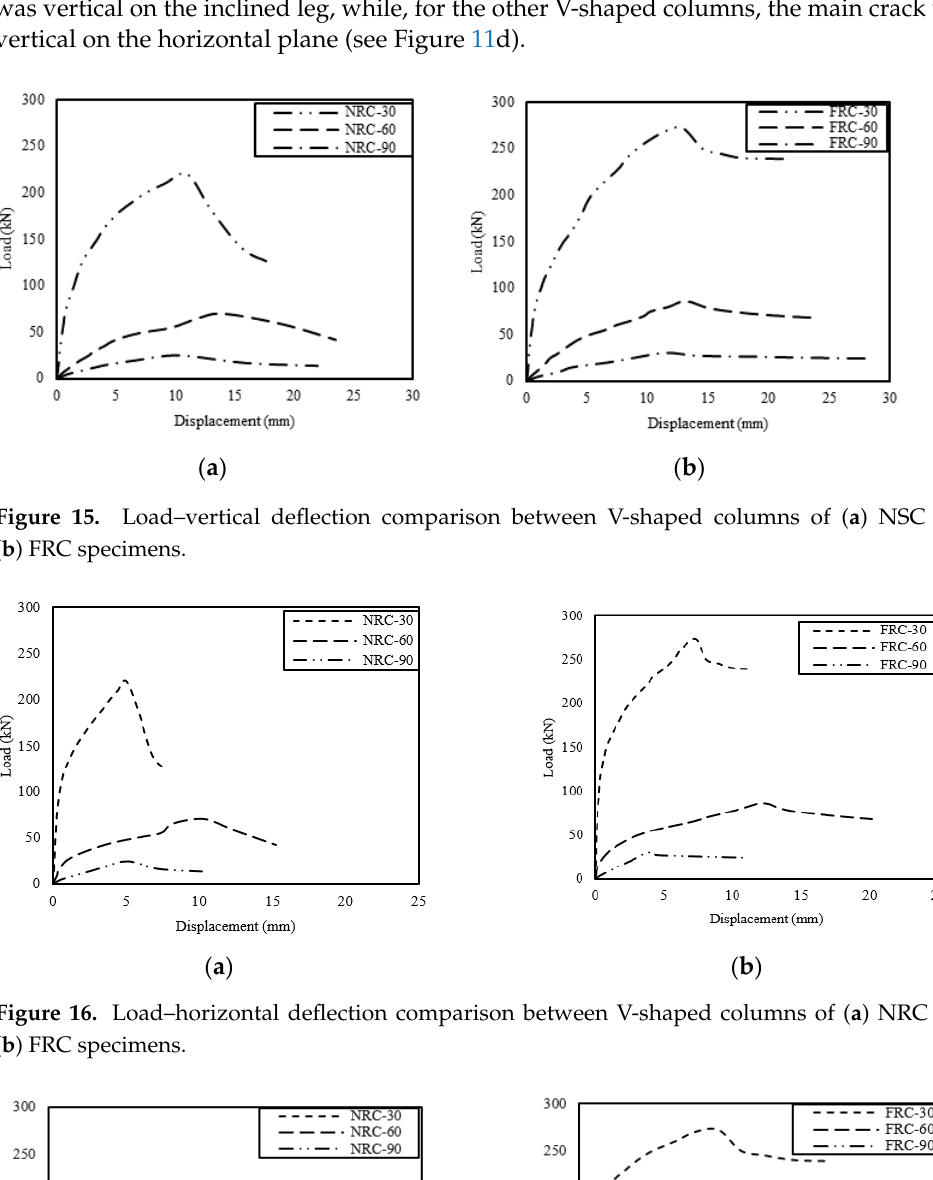
Figure 16. Load – horizontal deflection comparison between V-shaped columns of ( a ) NRC and ( b ) FRC specimens. ( b ) FRC specimens.